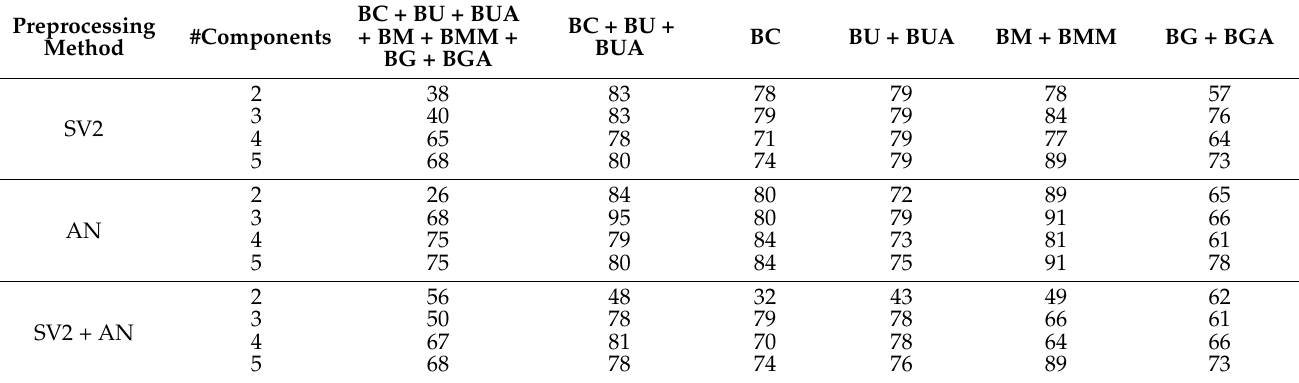
Table 3. Accuracy (%) of PCA-LDA analysis based on FT-NIR spectra preprocessed by second derivative (SV2), area normalization (AN), and second derivative and area normalization (SV2 + AN), to predict if biodiesel is contaminated, if it is contaminated with VOs (BC + BU + BUA), RSO (BC), UCO (BU + BUA), methanol (BM + BMM), or glycerol (BG +